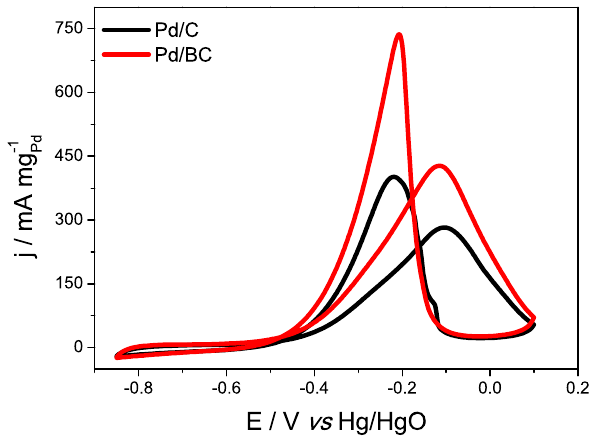
Fig. 6 Voltammograms of Pd/C and Pd/BC in 1 moL L −1 KOH + 1 moL L −1 ethanol at 20 mVs −1